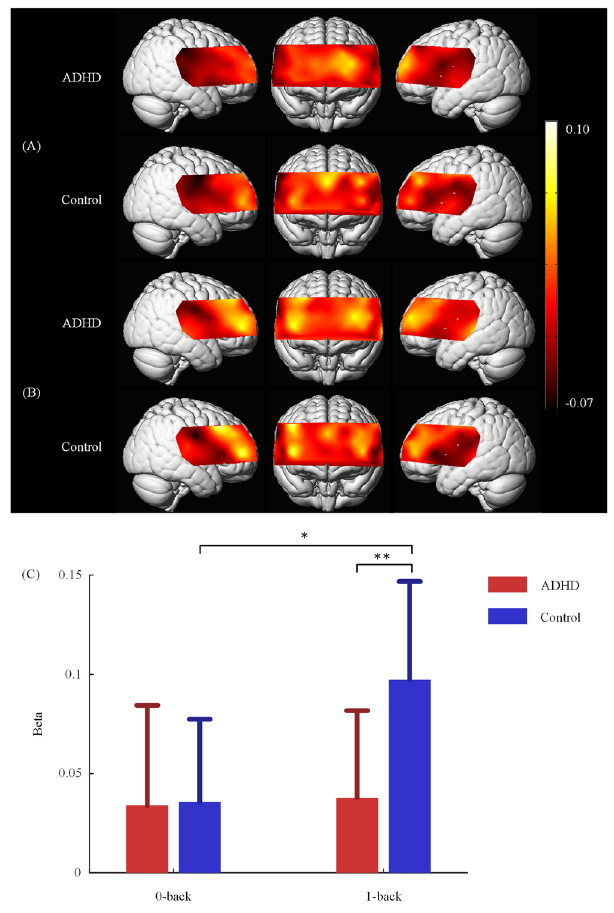
Figure 1. fNIRS activation maps for 0-back condition ( A ) and 1-back condition ( B ). The beta values are indicated by color. The light colors represent strong cortical activations, and vice versa. Bar plots of beta values showing the beta values of channel 3 in each conditions for the ADHD and control group ( C ). Error bars represent the standard error of the mean. * p < 0.05; ** p <